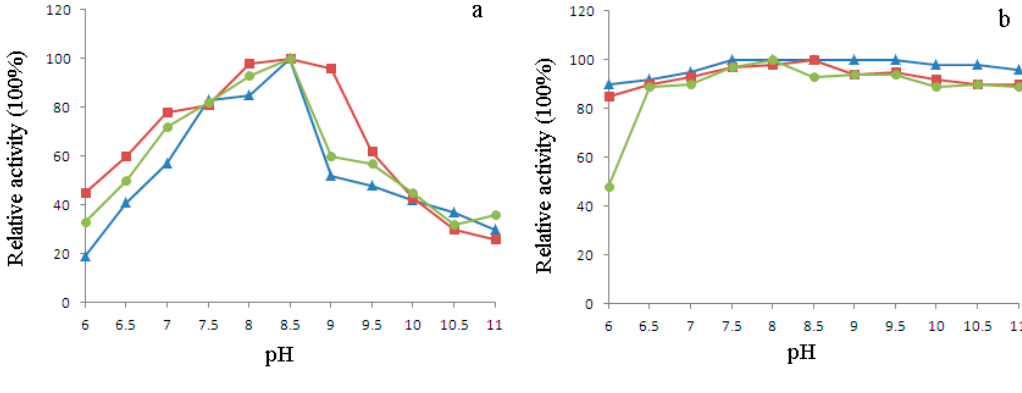
Figure 9. Effect of pH on uricolytic activity ( a ) and stability ( b ) of wPU ( ▲ ), PBC ( ■ ), and H 1-2 P 3 H 4 P 5-6 H 7-8 (E24D & E83G) ( ● ). Enzyme activity at the optimum pH (activity) or at the beginning of incubation (stability) was assumed to be 100%.